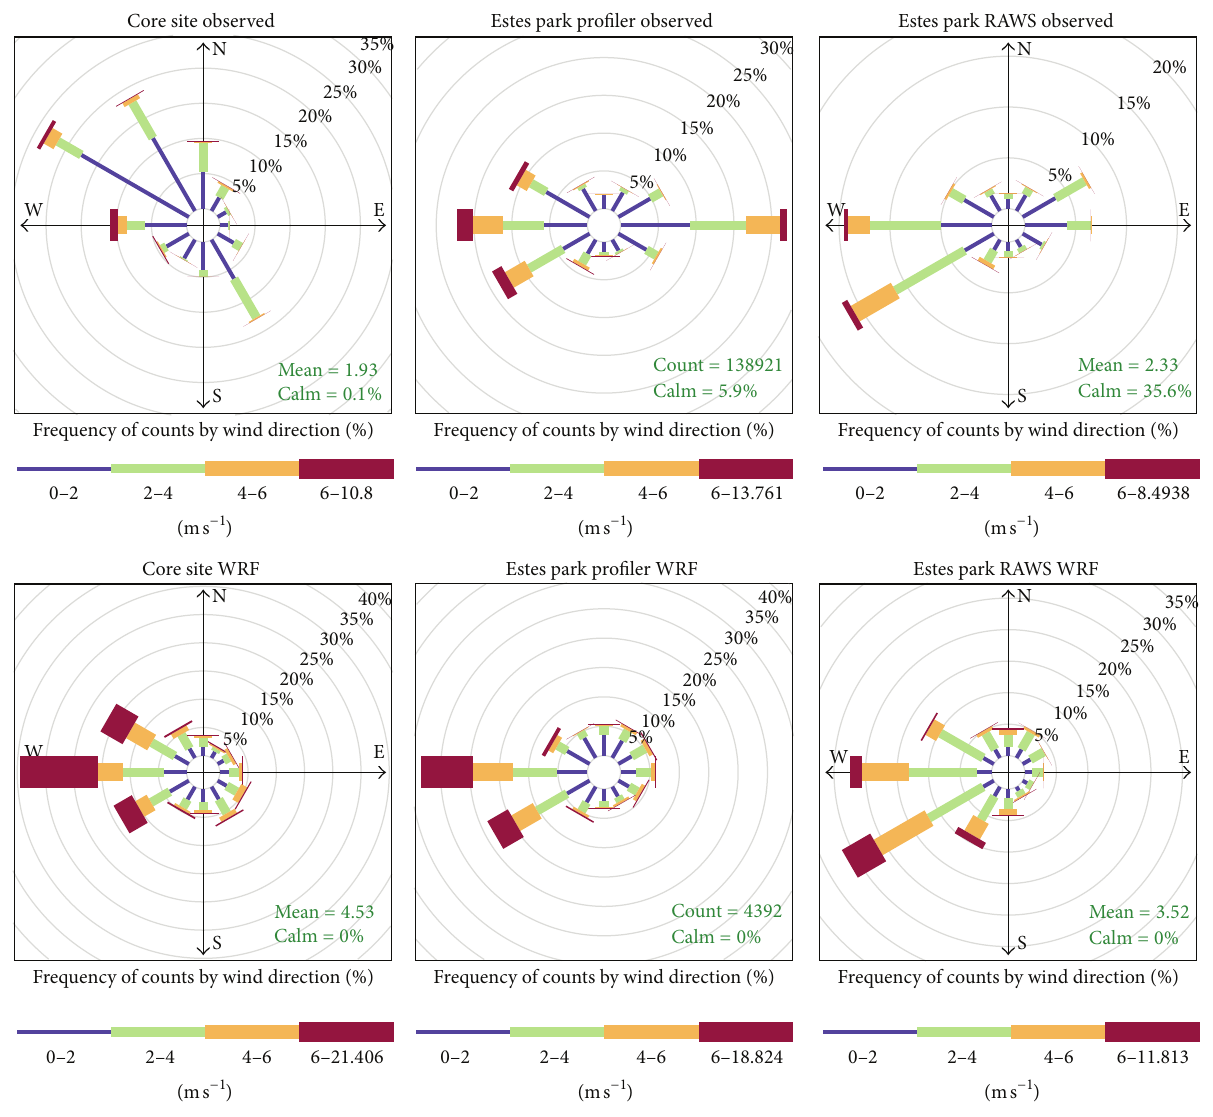
Figure 6: Wind roses showing the percent of winds from each of 12 directional bins for 10-meter winds during May–Nov 2009 as observed and as modeled by WRF at the core site, at the Estes Park radar wind profiler site and at the Estes Park RAWS site. Each light gray circle represents 5%